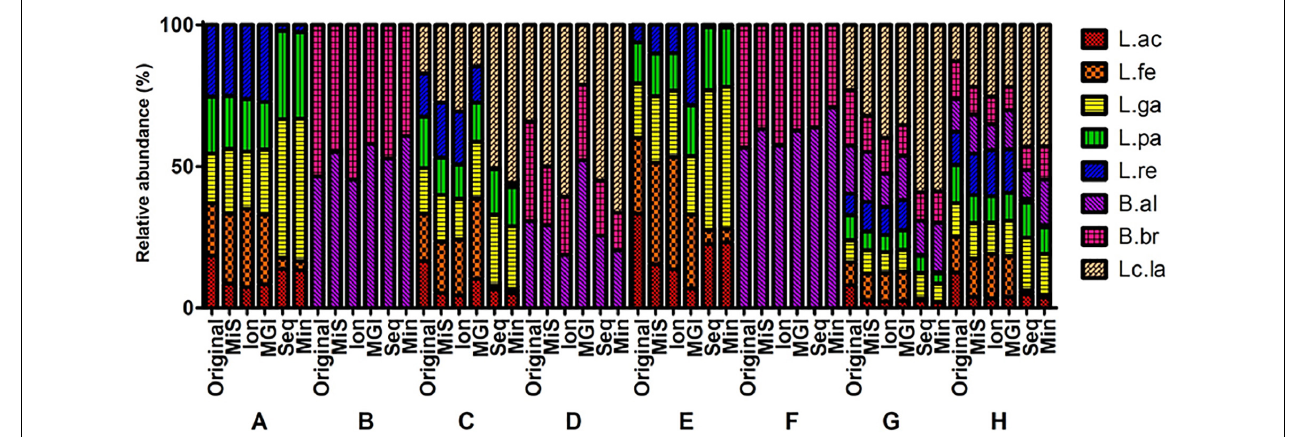
FIGURE 5 | Comparison of V3 region sequencing analysis of mock communities by five NGS platforms. Original, MiS: MiSeq, Ion: IonTorrent, MGI: MGIseq-2000, Seq: Sequel, Min: MinION. A–H indicates specific mock